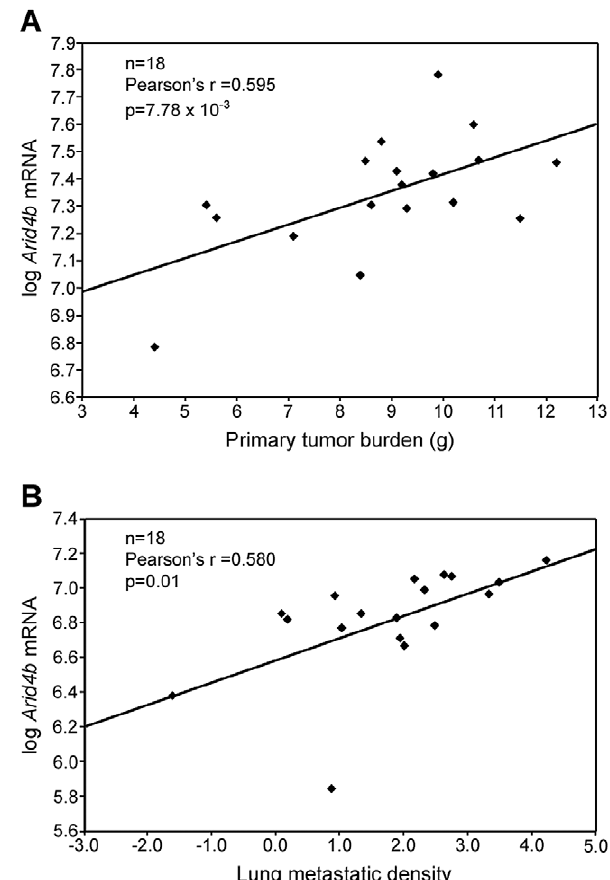
Figure 1. Arid4b expression is correlated with tumor growth and metastasis. Gene expression microarray data from 18 of the AKXD recombinant inbred strains shows expression of Arid4b is positively correlated with tumor burden (A) and metastatic density (B). The formula used to calculate metastatic density was ln[(metas- tases/um 2 ) 6 10 8 ].